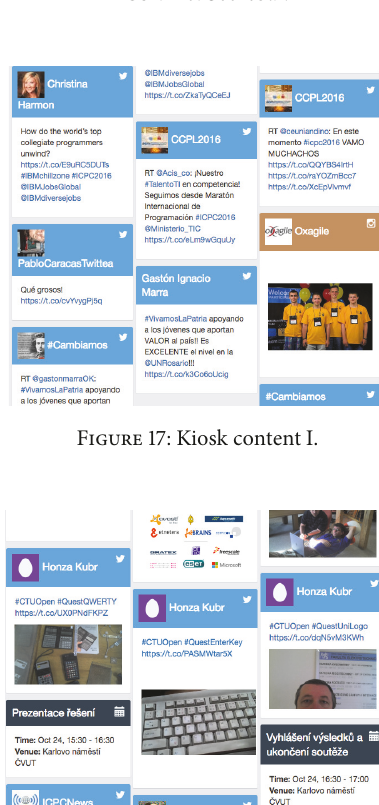
Figure 13: Team statistics and history.